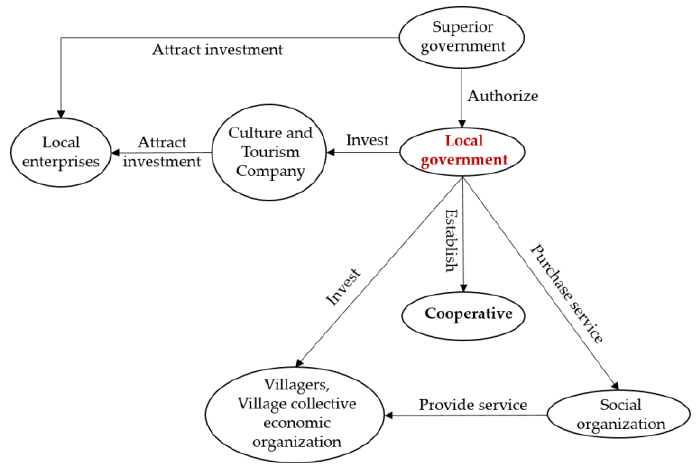
Figure 6. Construction and operation relationship of multiple entities of